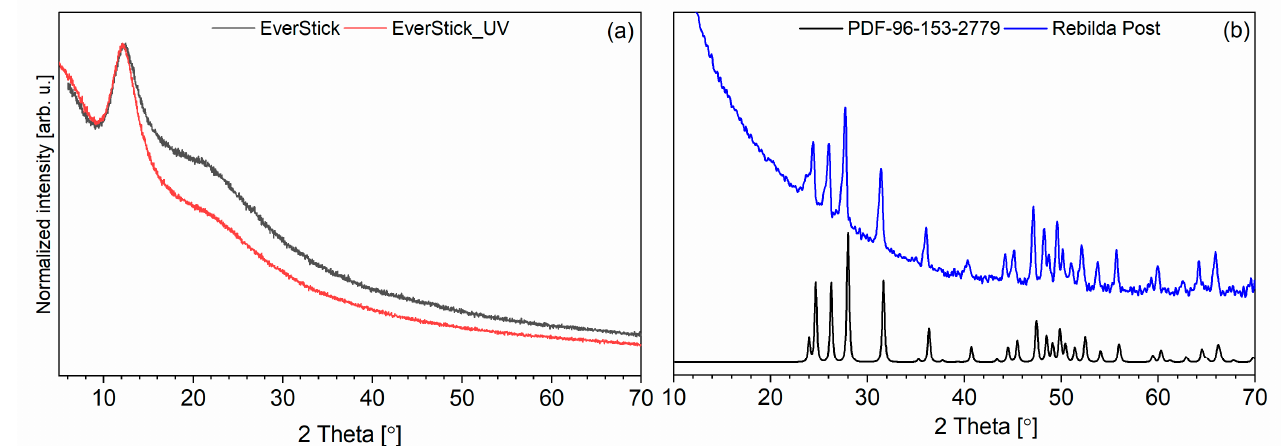
Figure 5. X-ray diffraction pattern of neat EverStick post and UV light-cured EverStick post ( a ) as well as Rebilda Post and PDF theoretical pattern of YbF 3 (PDF-96-153-2779) ( b ).